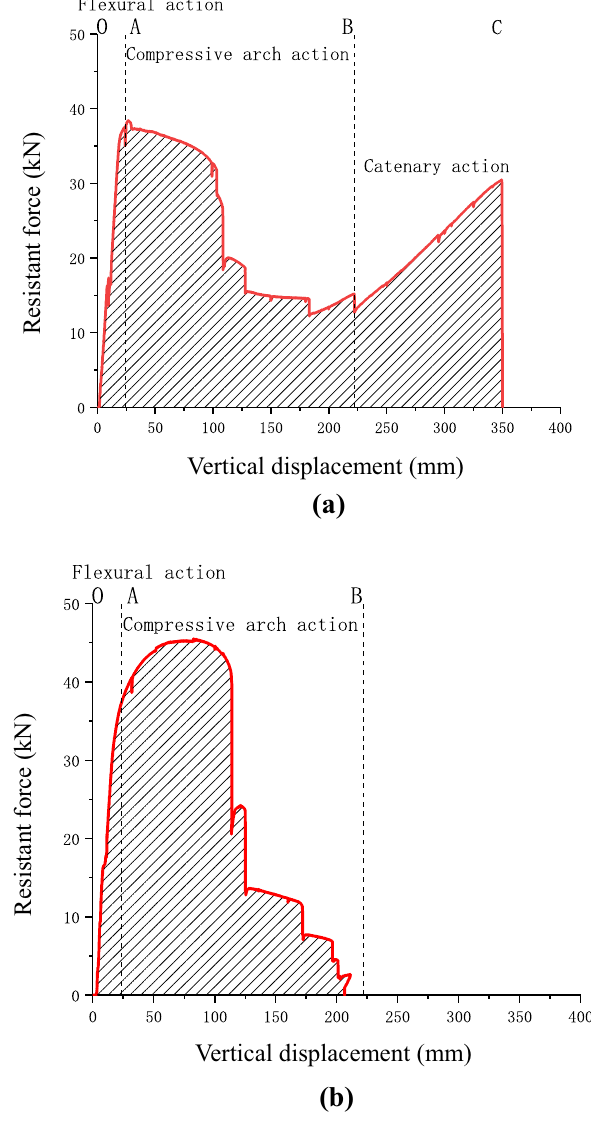
Figure 12: Schematic of the energy dissipation capacity of the spe - cimen: ( a ) S1 and ( b )